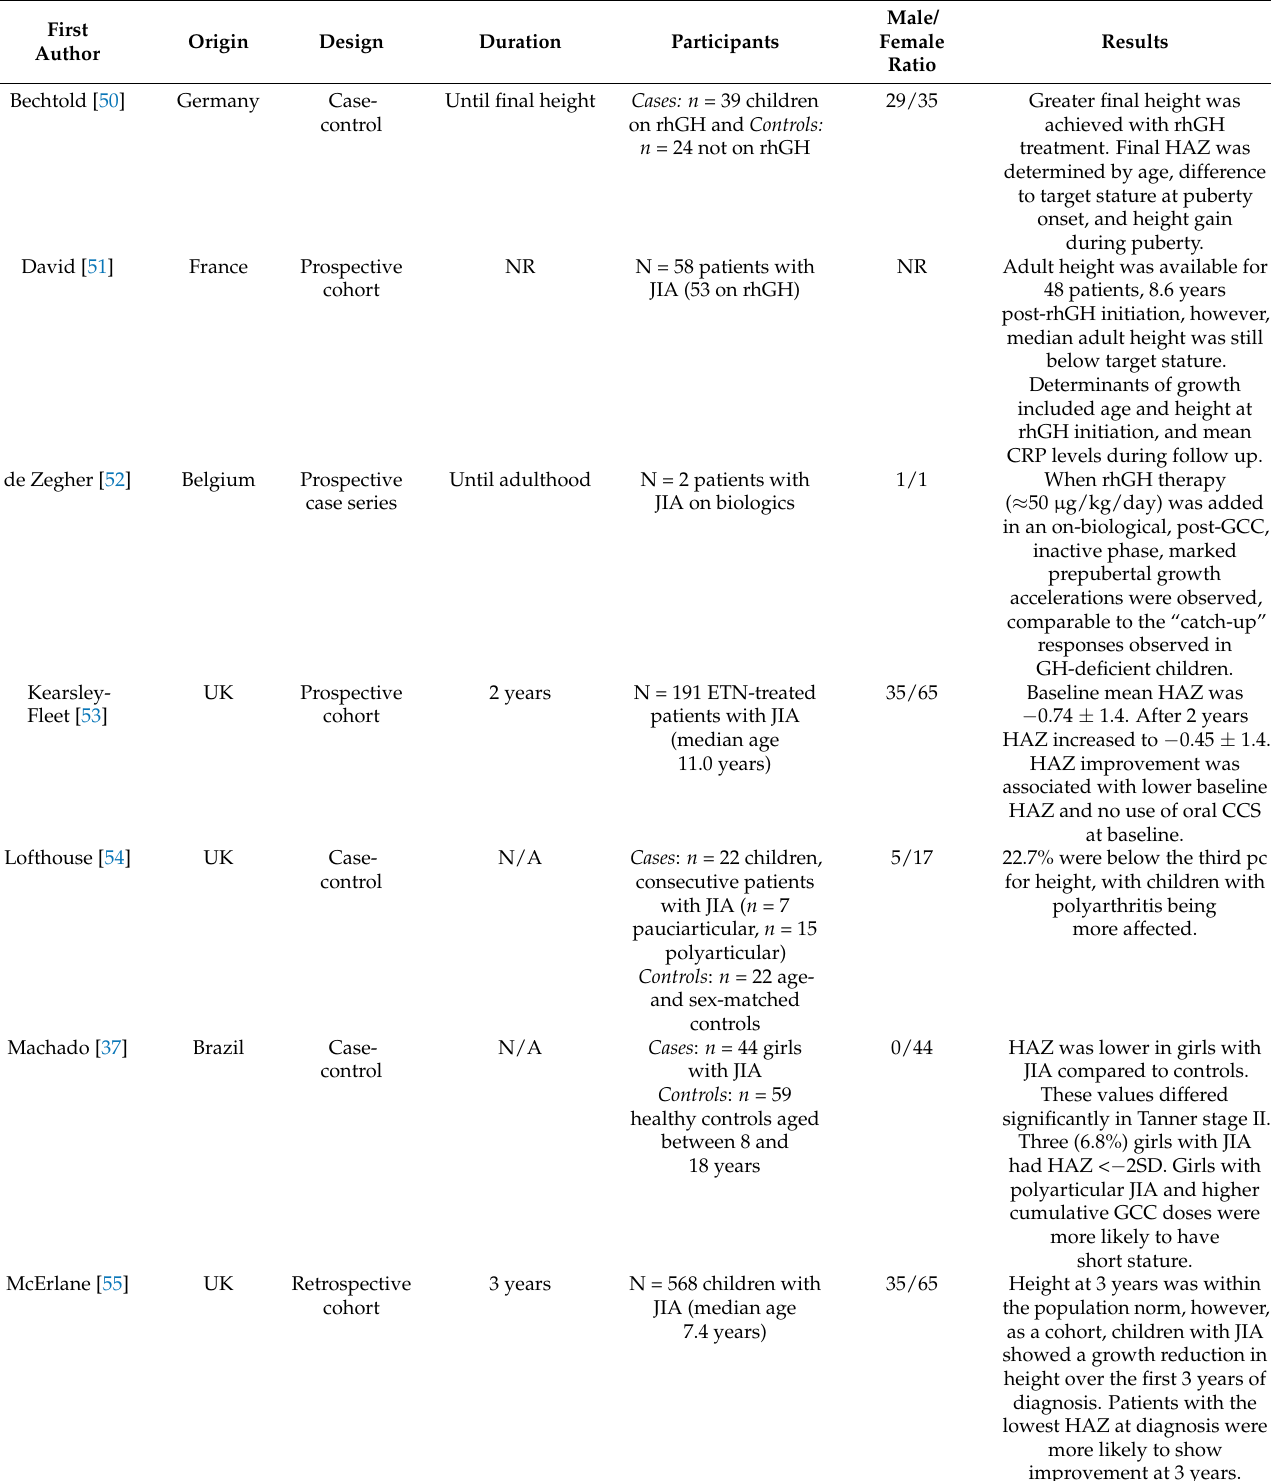
Table 1. Research on growth disorders in children with